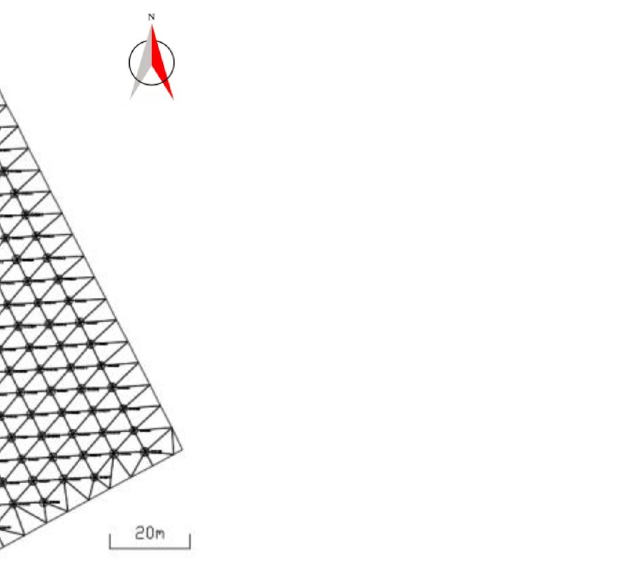
Figure 10. Triangle grid of blasting range.